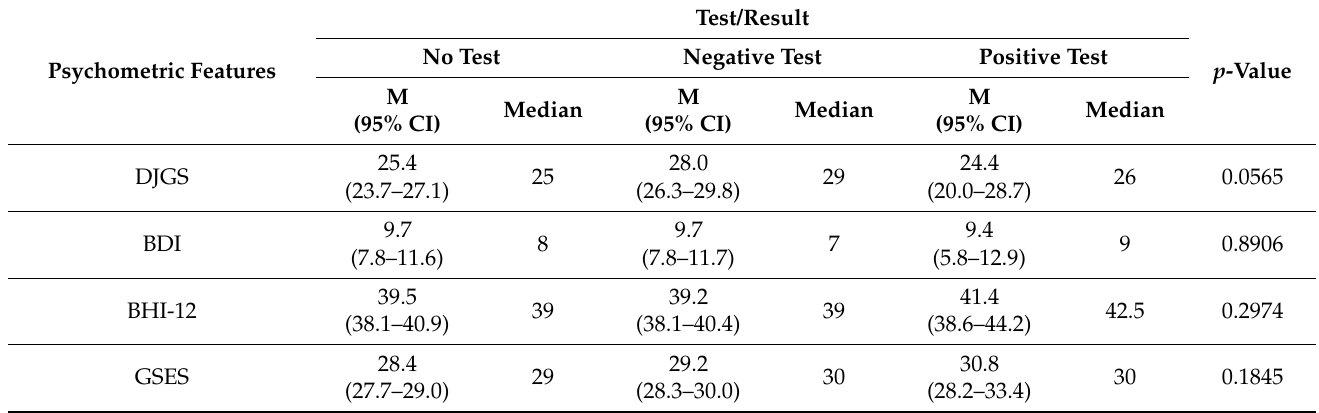
Table 9. Correlations between the psychometric scales used and the result of the COVID-19 test.